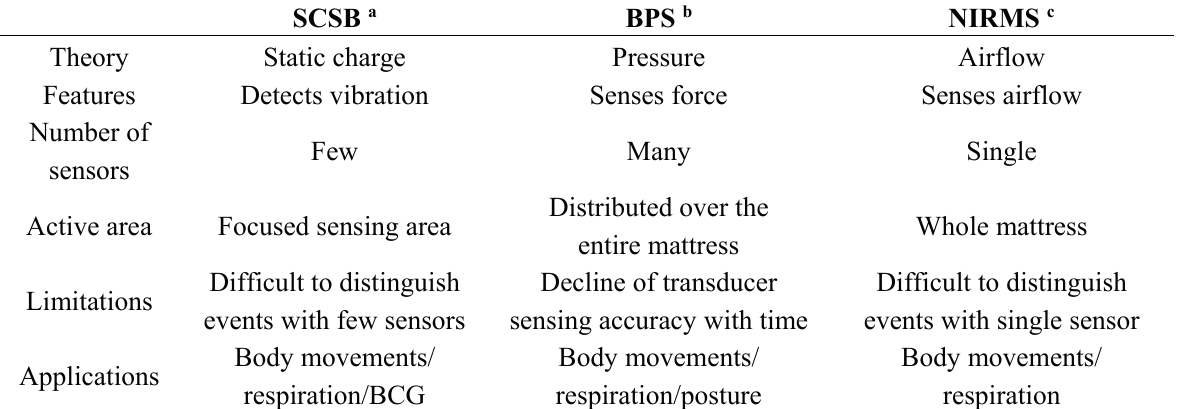
Table 1. Methods used and sensing in traditional respiratory monitoring systems built into